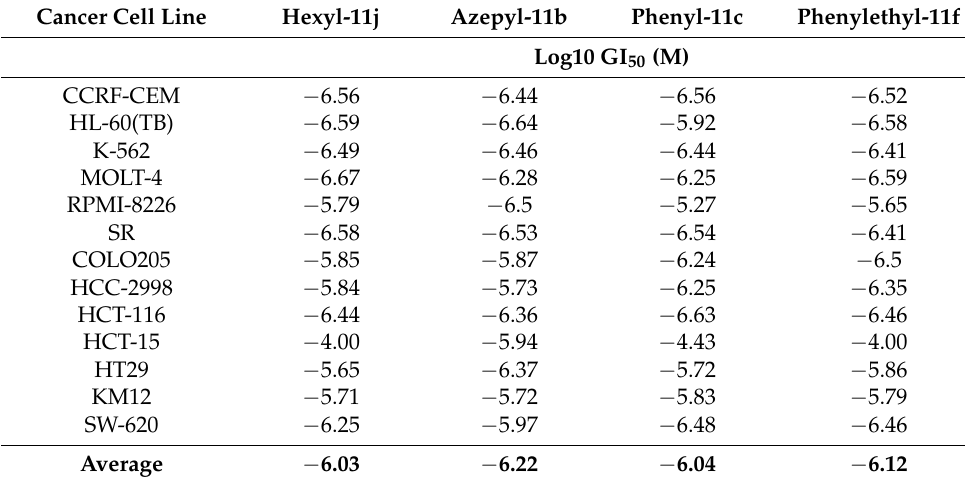
Table 4. Decimal logarithm of growth inhibition concentration (GI 50 ) for ureas 11b , 11c , 11f and 11j . GI 50 values are given as a molar concentration.